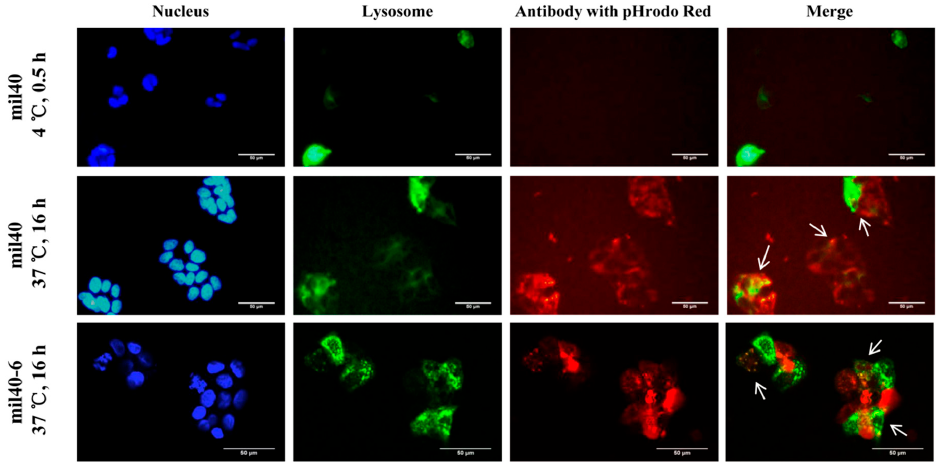
Figure 5. Receptor-mediated internalization of ADC mil40-6 by HER2 + breast cancer cell line BT-474. Red fluorescence-labeled mil40-6 (1 μ g/mL) was incubated with GFP-labeled BT-474 cells at 37 °C for 16 h while mil40-6 was endocytosed into the cell and located in lysosomes. The cell nuclei were stained with DAPI (blue), the lysosomes were labeled with a lysosomes-GFP (green), and the antobody were labeled with pHrodo Red (red). GFP: green fluorescent protein; DAPI: 4 ′ ,6-diamidino-2-phenylindole. Scale bar = 50 μ m.